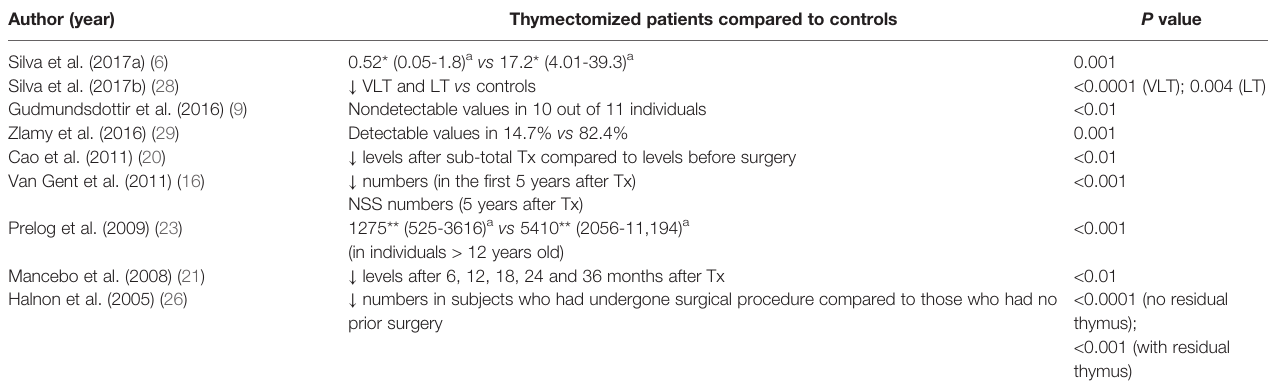
TABLE 5 | Main results regarding numbers of TRECs of included